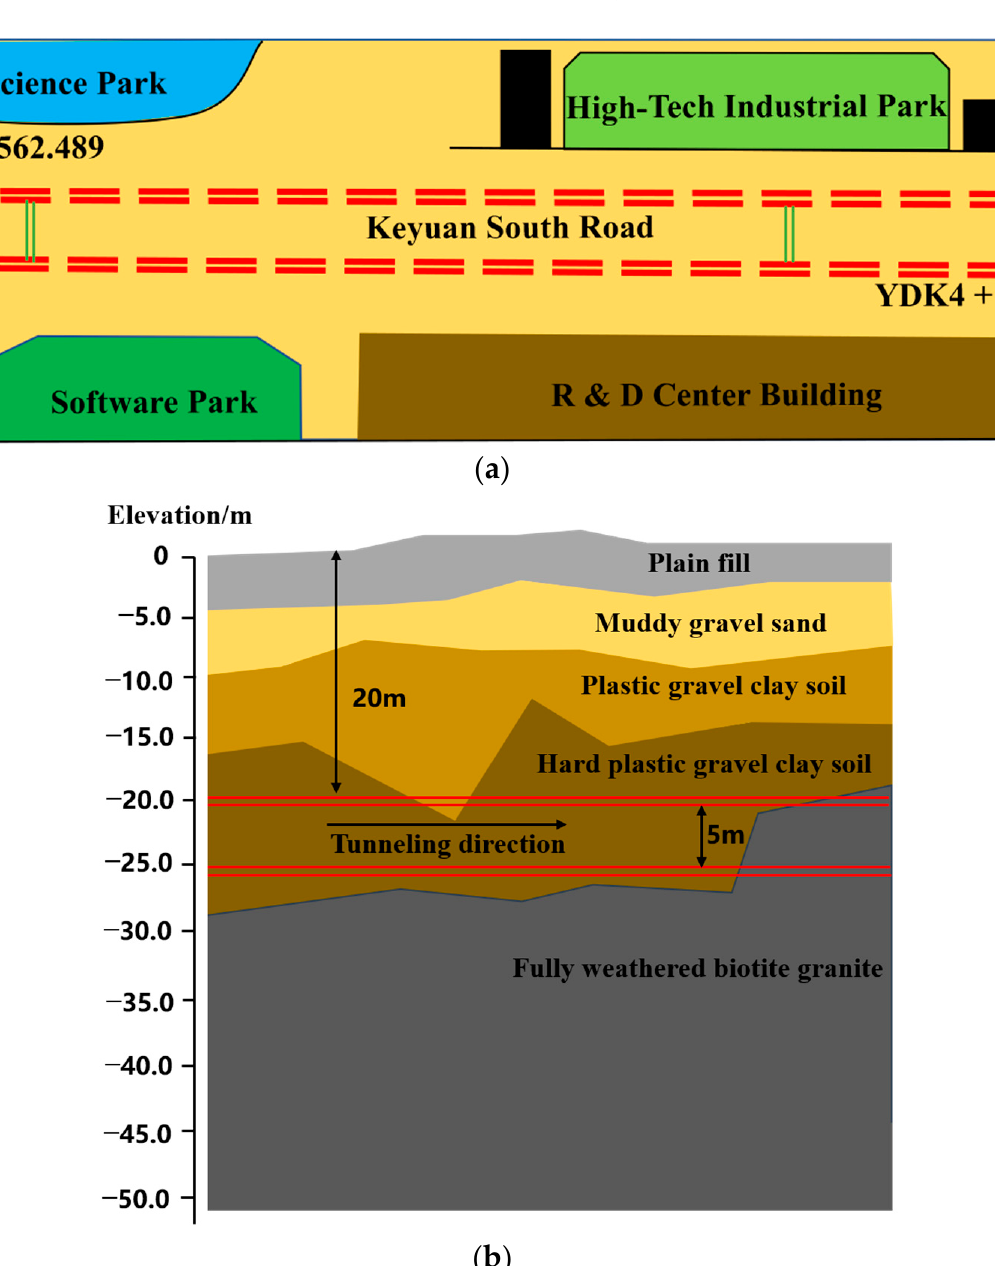
Figure 1. Engineering environment diagram. ( a ) A schematic view of the study site. ( b ) Stratum structure diagram.